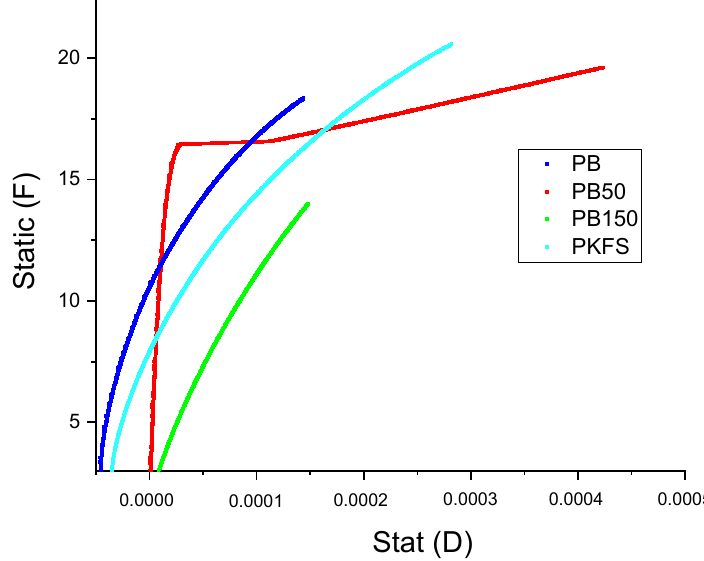
Figure 4. Overlay of force vs. deformation trend of all the bread samples after 6 days.